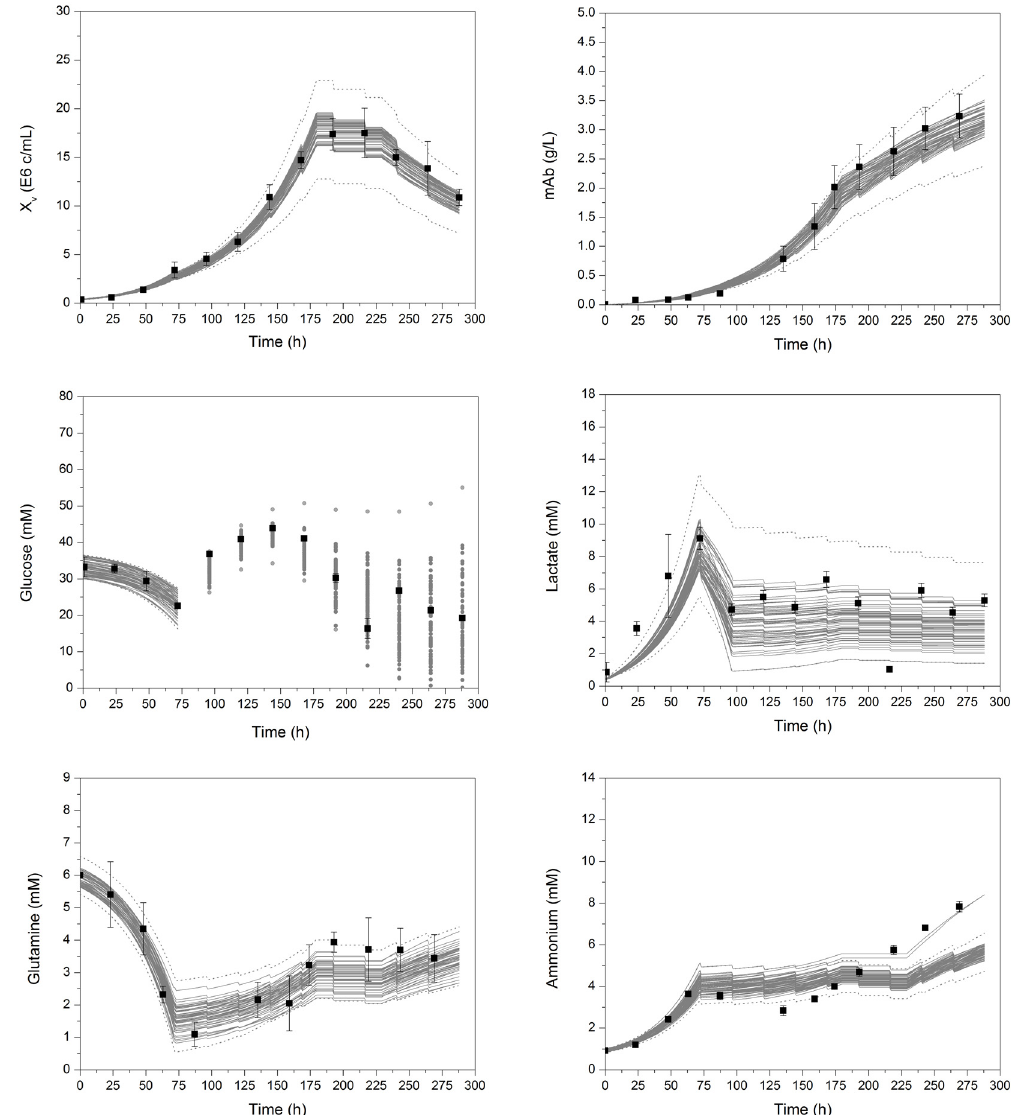
Figure 6. Enveloped curves of each process variable resulting from 100 model parameter error-based Monte Carlo simulations. Xv, viable cell concentration; mAb, monoclonal antibody. Black square dots represent experimental data. Error bars comprise the standard deviation of three cultivations. For better clarity and visualization, the enveloping curves for glucose after 72 h show the starting concentrations before respective feed addition. The detailed course of glucose between feed additions can be seen in Figure 2.